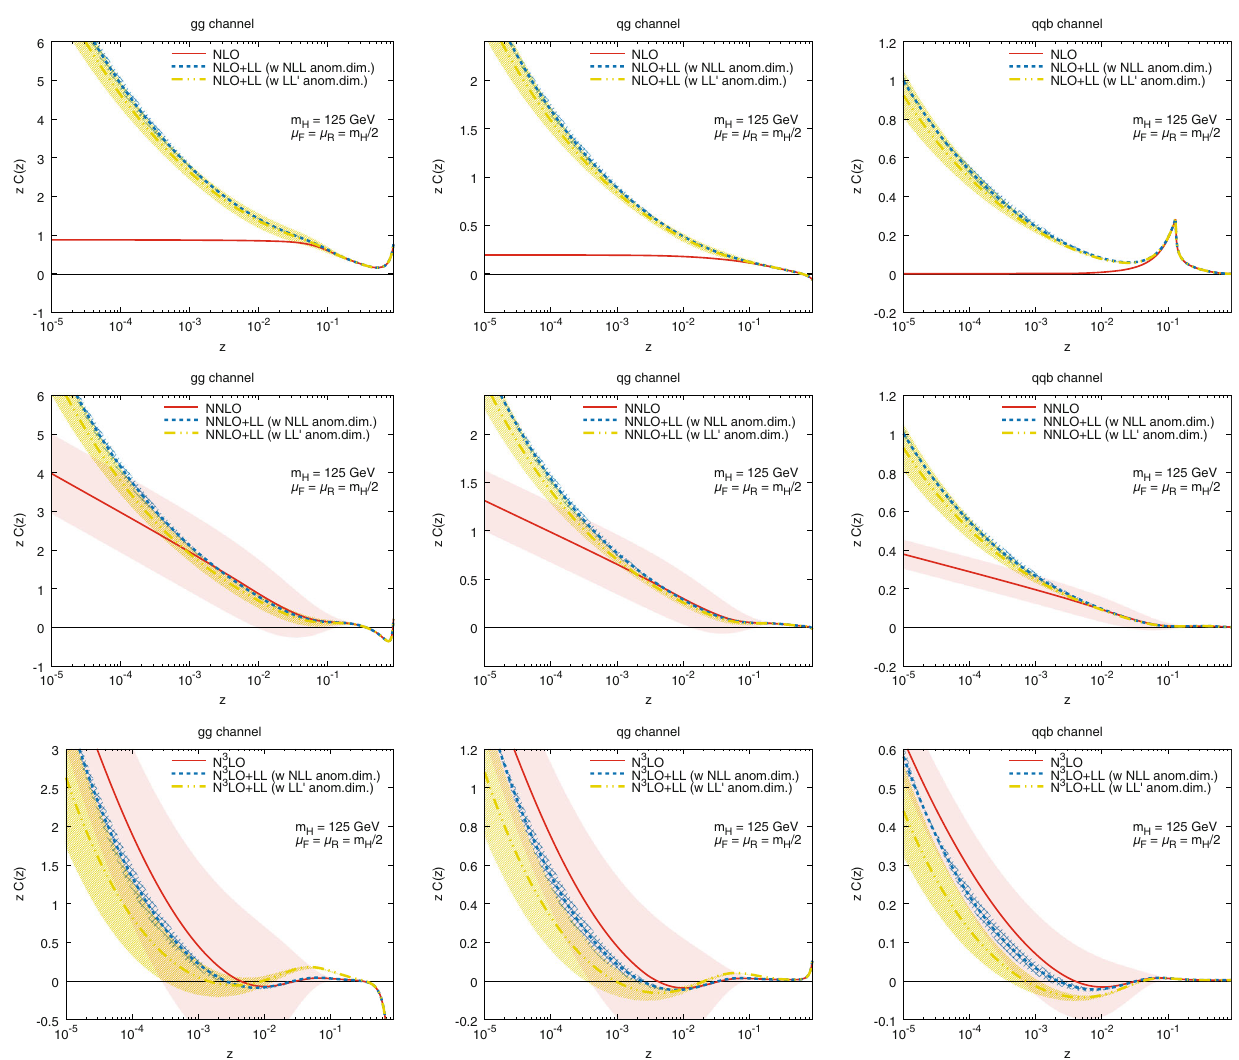
Fig. 3 Partoniccoefficientfunctionsfor ggH productionatfixedorder in solid red and fixed order plus resummation in two different imple- mentations: dashed blue is the new implementation that uses the NLL